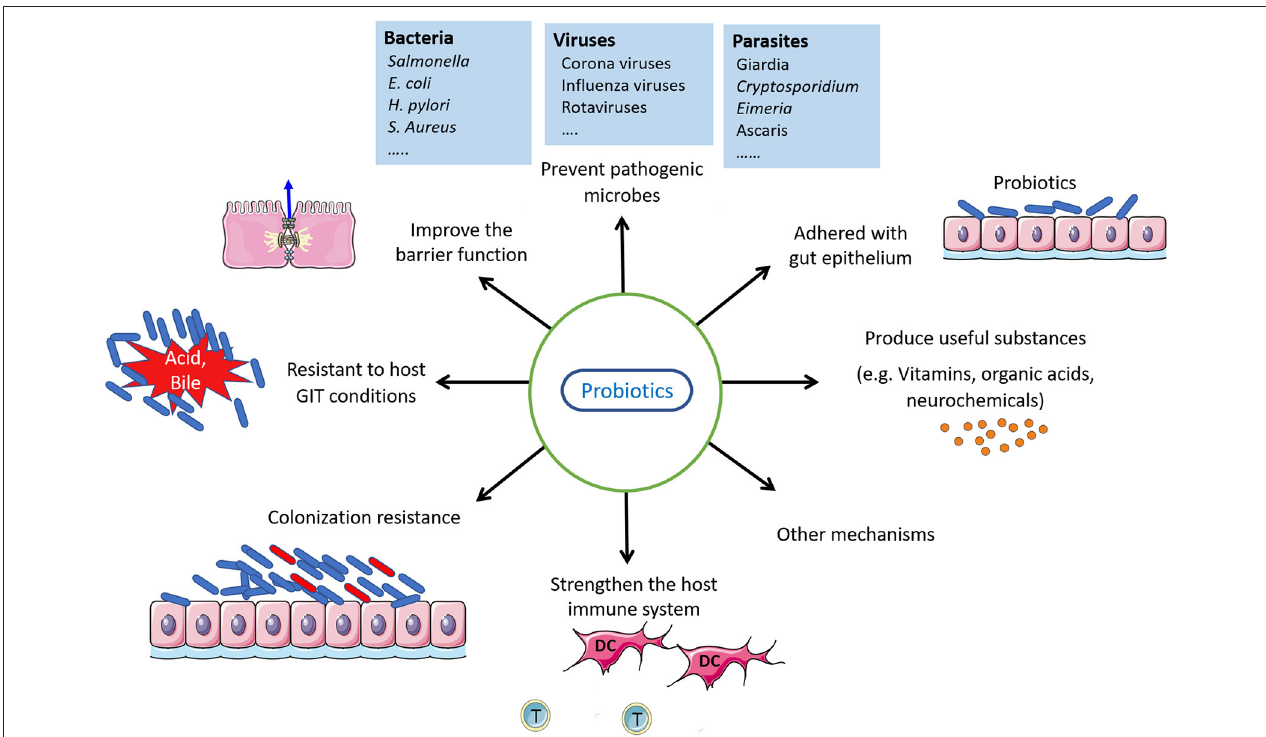
FIGURE 1 | Probiotics properties and their